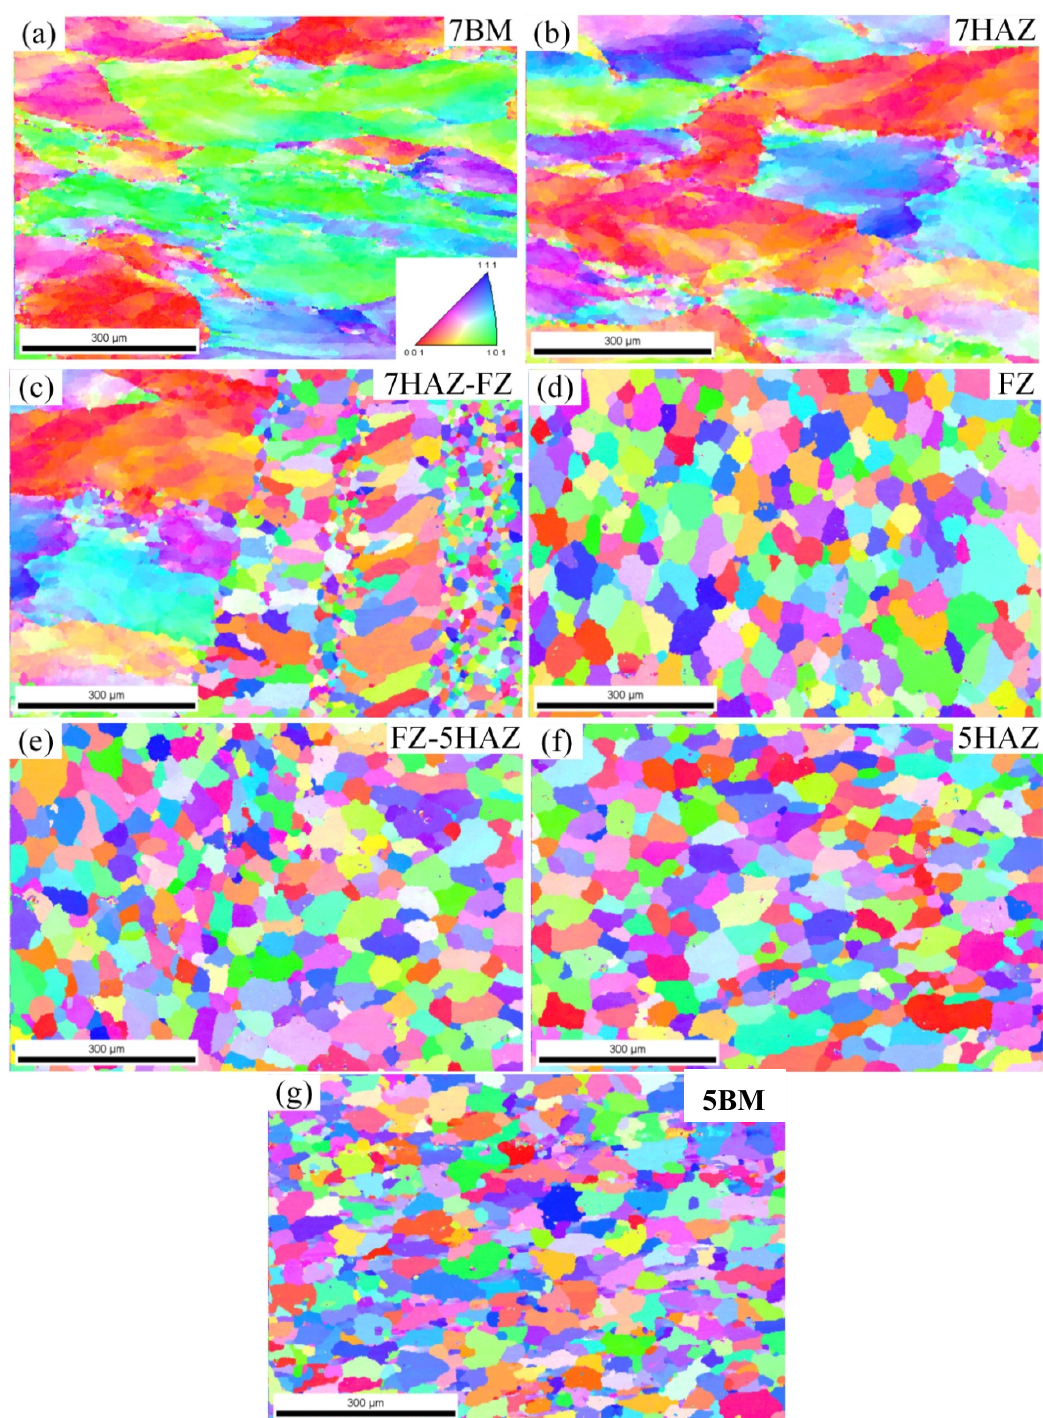
Figure 8. EBSD study of the microstructures of different parts of the two alloys in the weldment. The parts correspond to the EBSD images are indicated in the top right corners. ( a ) 7BM; ( b ) 7HAZ; ( c ) 7HAZ-FZ; ( d ) FZ; ( e ) FZ-5HAZ; ( f ) 5HAZ; ( g ) 5BM.